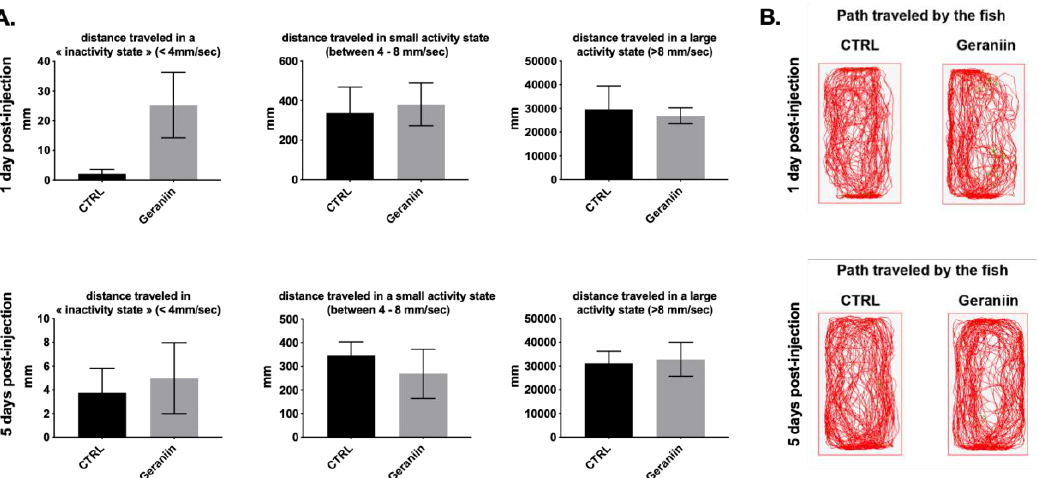
Figure 5. Geraniin did not impair fine-tuned locomotor activity at 1 day and 5 days post injection. ( A ) distance travelled in “inactivity” ( < 4 mm / s), small activity (4–8 mm / s), and large activity ( > 8 mm / s) states in fish injected with geraniin at 1 day post injection and 5 days post injection. Note that no significant di ff erences were observed compared with the PBS-injected fish (CTRL). ( B ) representative paths traveled by PBS-injected fish and geraniin-injected fish at 1 and 5 days post injection. Data represent the means ± SEM.